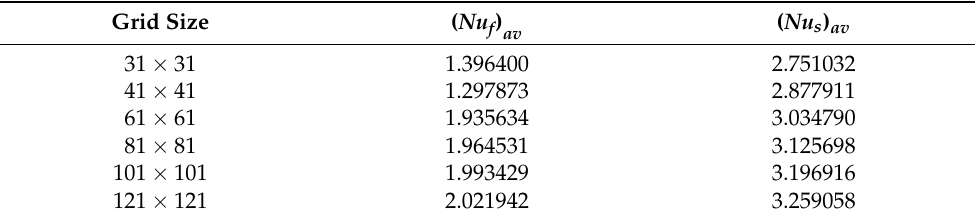
, 𝛾 = 0 . , γ = 0. (cid:2871) 3